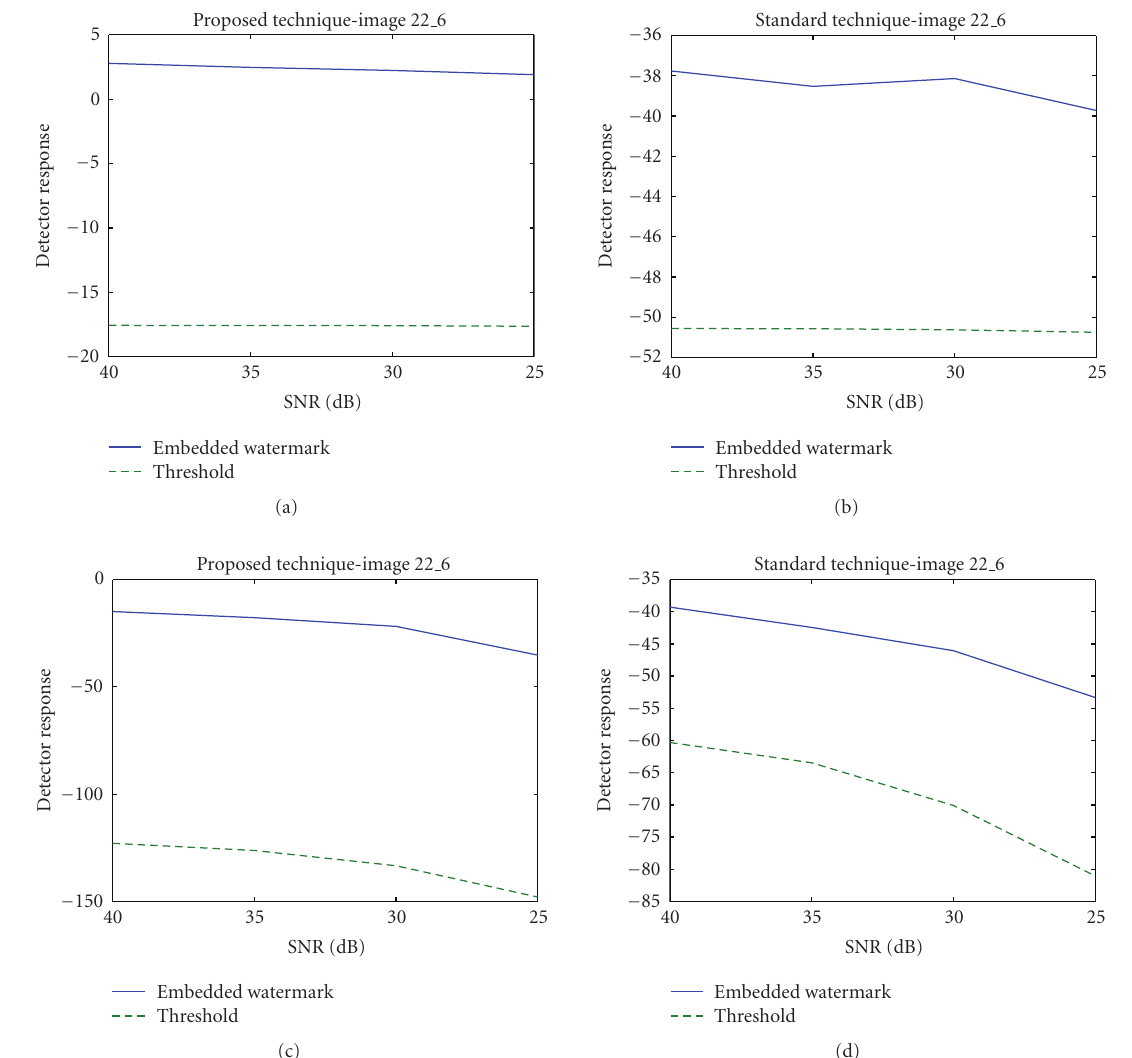
Figure 12: Robustness against additive white Gaussian noise. Top: DWT domain. Bottom: DFT domain. Left side graphs: Proposed technique. Right side graphs: Standard